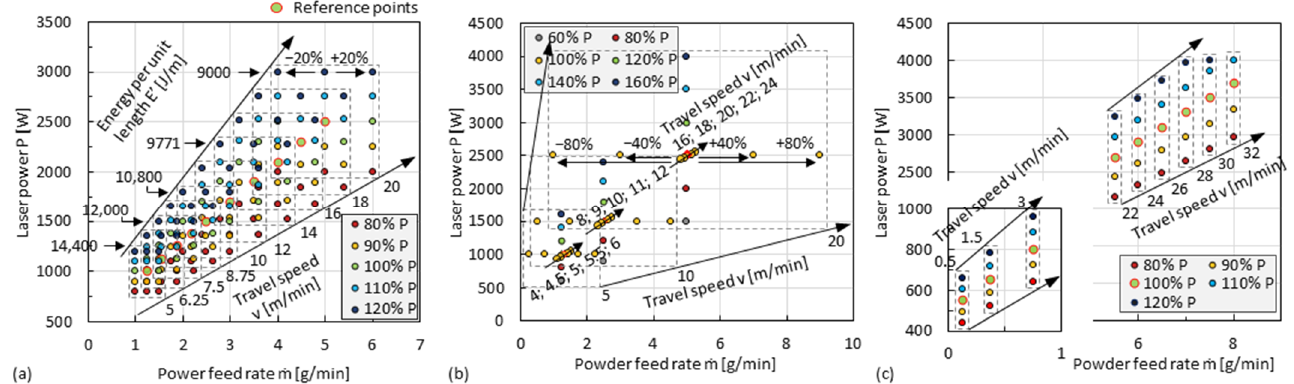
Figure 6. Parameter sets of laser power P , travel speed v , and powder feed rate ˙m for fabricated single tracks. ( a ) The reference points are set according to P [W] = 500 [W] + 100 [W · min/m] × v [m/min] and ˙m [g/min] = 0.25 [g/m] × v [m/min], and the extended points are obtained by varying P ( ± 10%, ± 20%) and ˙m ( ± 20%) proportionally, and the travel speed of each of the 15 points framed by a dotted line is the same; ( b ) Further points are obtained by varying P (60–160%), ˙m ( ± 40%, ± 80%), and v ( ± 10%, ± 20%) proportionally based on the reference points of ( a ) at v = 5 m/min, 10 m/min, and 20 m/min; ( c ) Further reference points are set according to the same equations of ( a ), and v = 22~32 m/min, and the extended points are obtained by varying the P ( ± 10%, ± 20%) proportionally, and the max. P is 4000 W. Laser spot Ø = 1.3 mm. Conveying gas flow rate = 5 l/min. Shielding gas flow rate = 10 l/min.